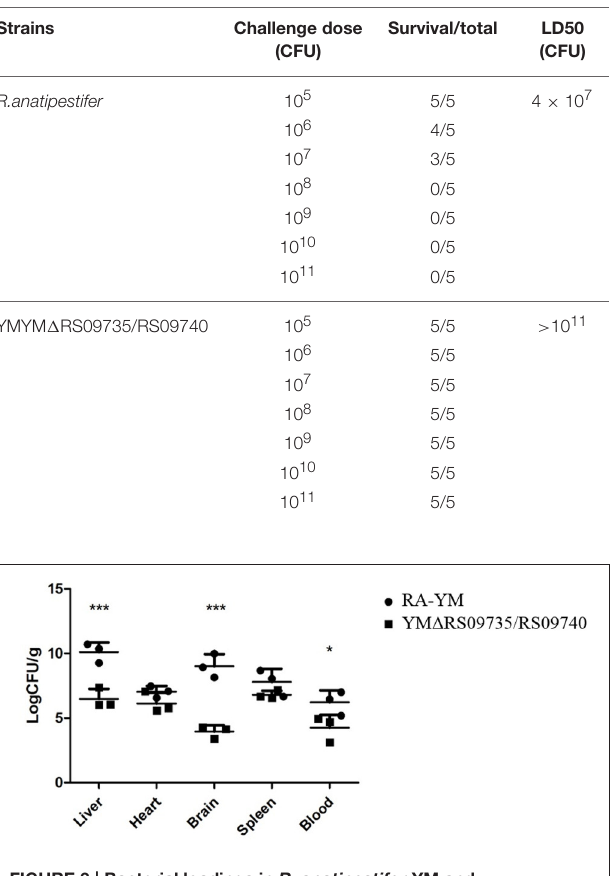
Survival/total LD50 (CFU) (CFU)